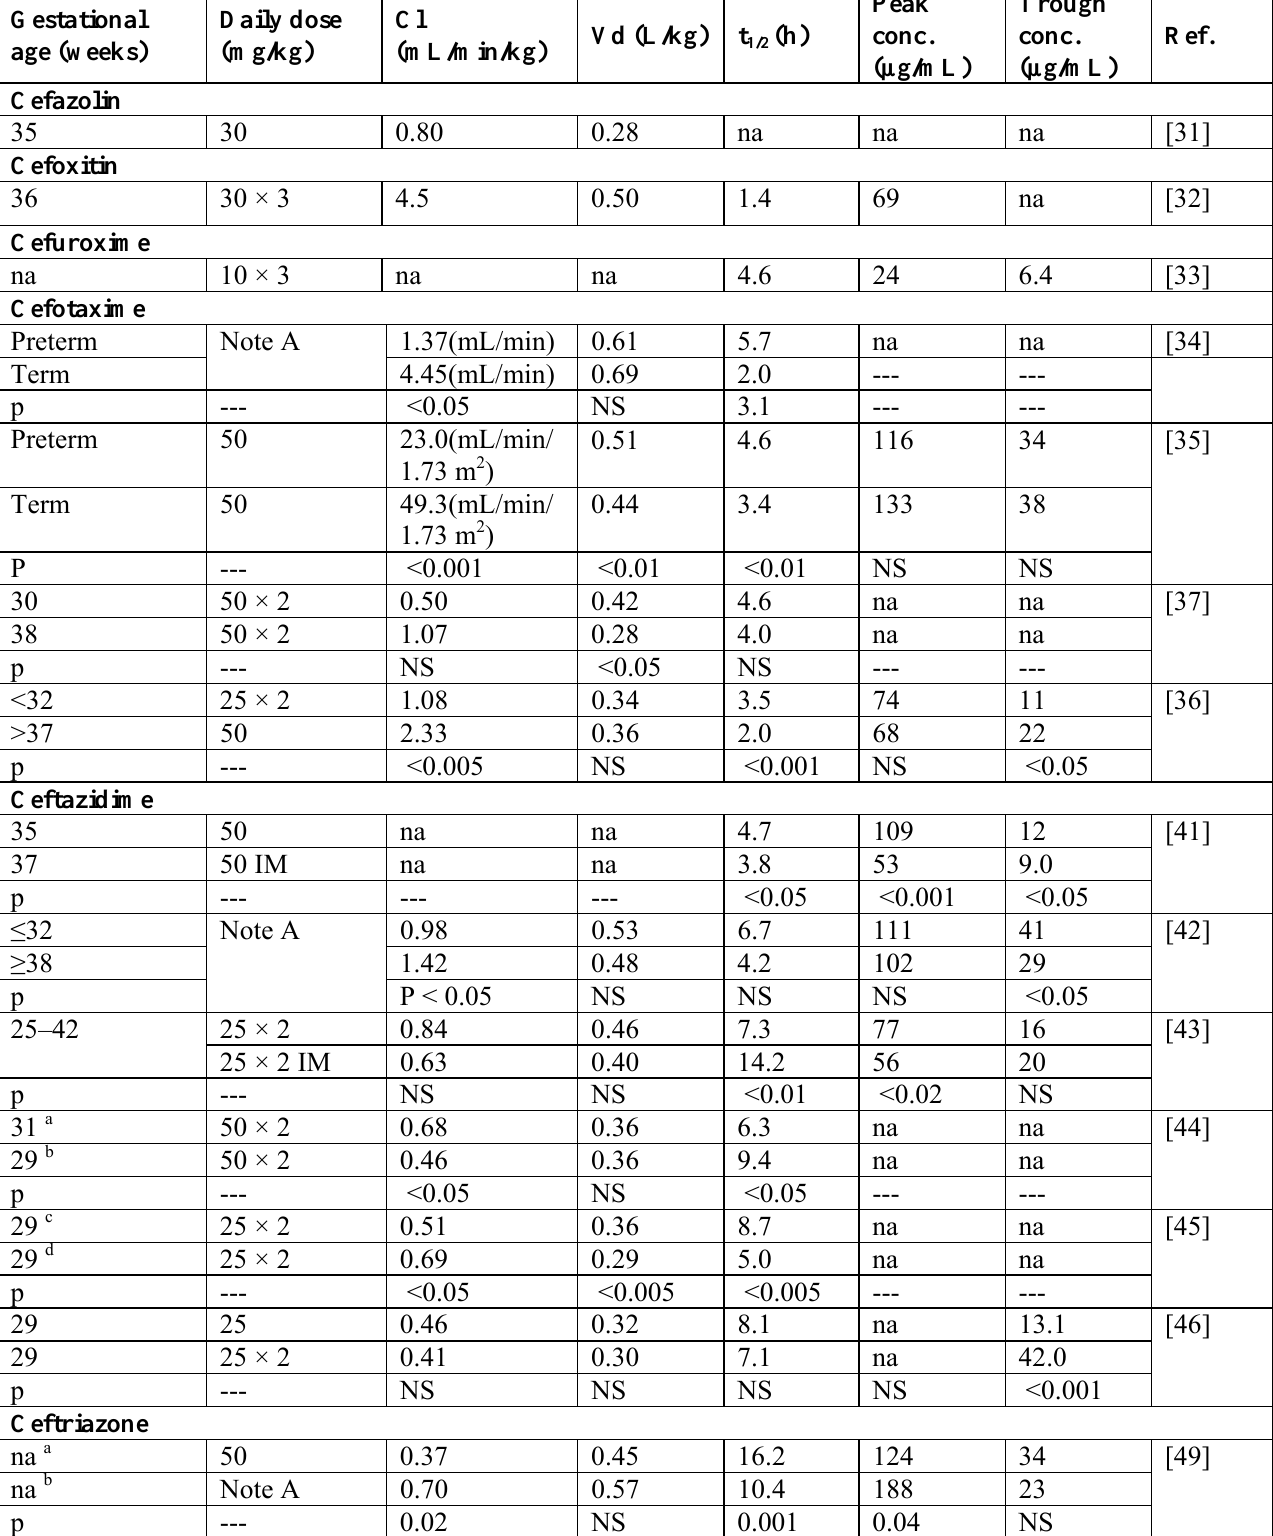
Table 4. Pharmacokinetic parameters of cephalosporins. Figures are the mean or